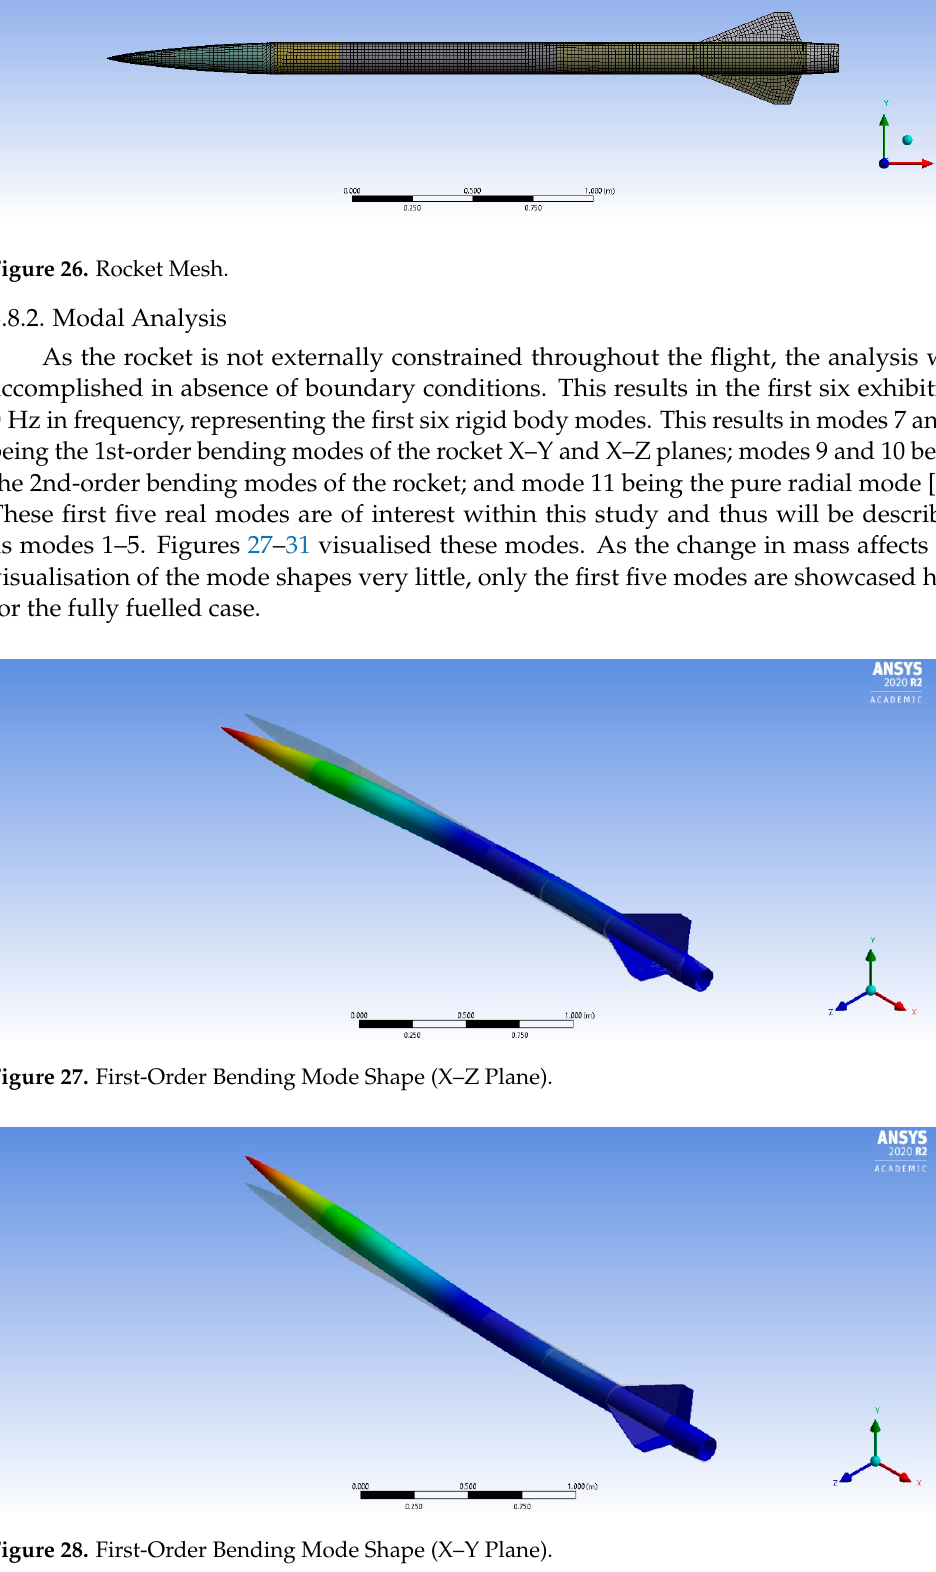
Figure 29. Second-Order Bending Mode Shape (X–Z Plane). Figure 30. Second-Order Bending Mode Shape (X–Y Plane).